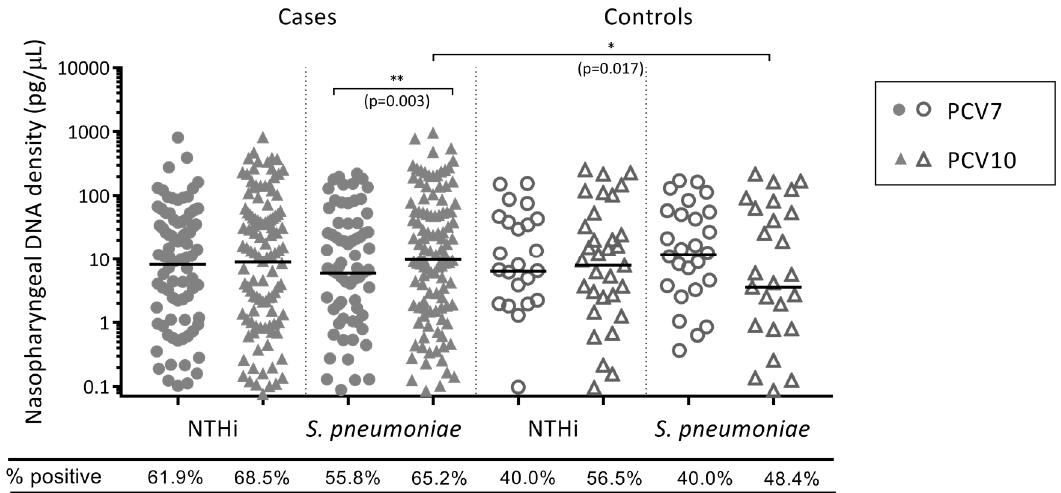
Figure 1. Otopathogen density in the nasopharynx of PCV7- and PCV10-vaccinated otitis-prone and non-otitis-prone children. Data are presented for children that were colonised with an otopathogen, with each point representing an individual child and the horizontal bars depicting the median otopathogen DNA concentration in pg/ µ L. Circles represent PCV7-vaccinated otitis-prone cases (closed circles) and non-otitis-prone control children (open circles), and triangles represent PCV10-vaccinated otitis-prone cases (closed triangles) and non-otitis-prone controls (open triangles). Statistical analysis was conducted on adjusted data, correcting for age and day-care attendance, where **: p < 0.01, *: p < 0.05 and ns: not significant. NTHi, nontypeable Haemophilus influenzae ; PCV, pneumococcal conjugate vaccine.